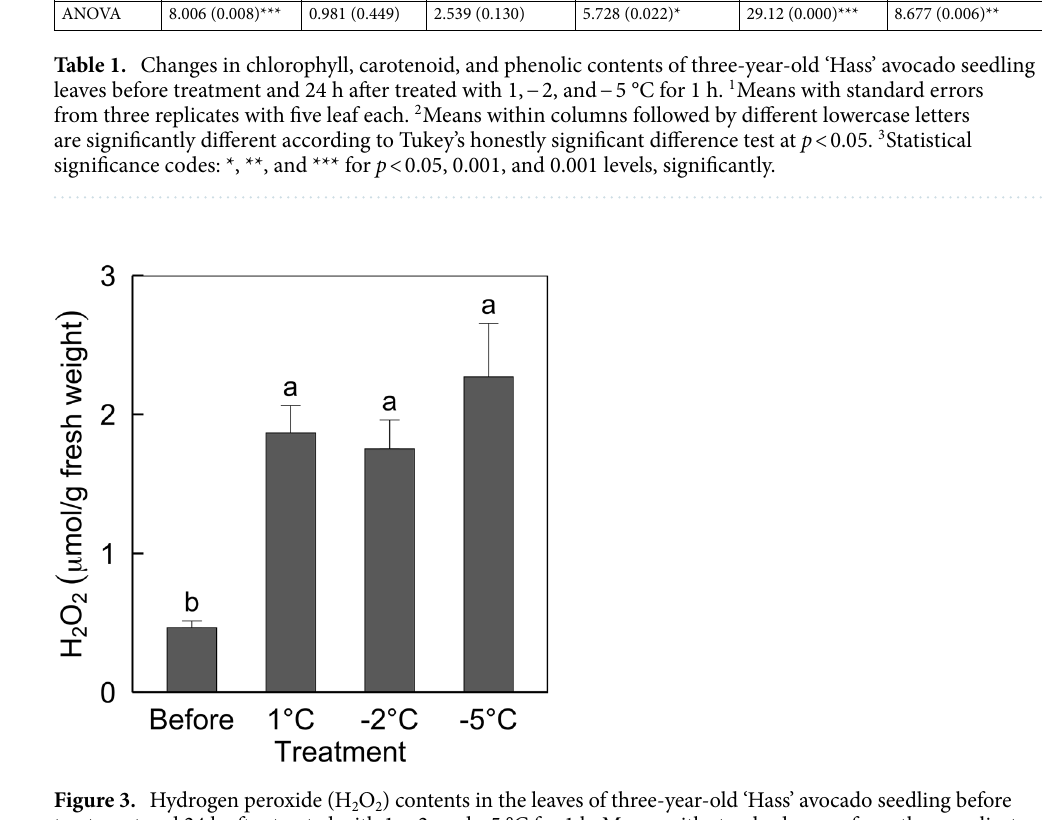
Figure 3. Hydrogen peroxide (H 2 O 2 ) contents in the leaves of three-year-old ‘Hass’ avocado seedling before treatment and 24 h after treated with 1, − 2, and − 5 °C for 1 h. Means with standard errors from three replicates with five leaf each. Means with bars followed by different lowercase letters are significantly different according to Tukey’s honestly significant difference test at p <